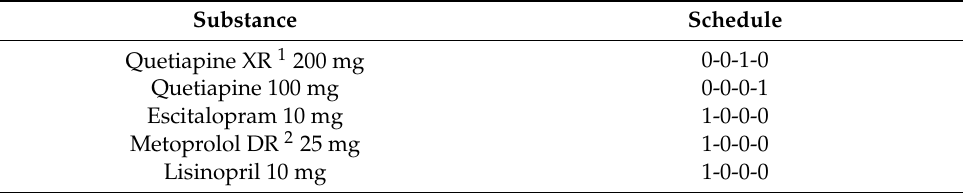
Table 3. Case #2 medication at the time of the reported severe ADRs.